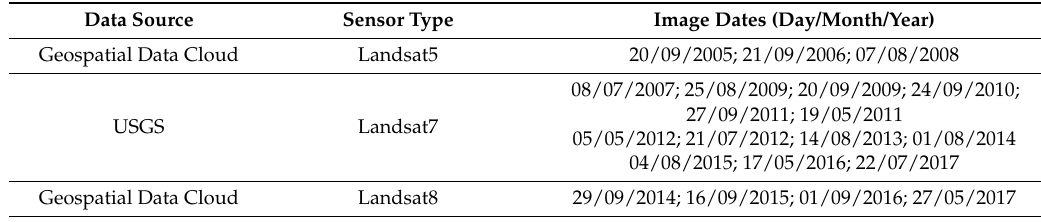
Table 1. A list of remote sensing image data sources.